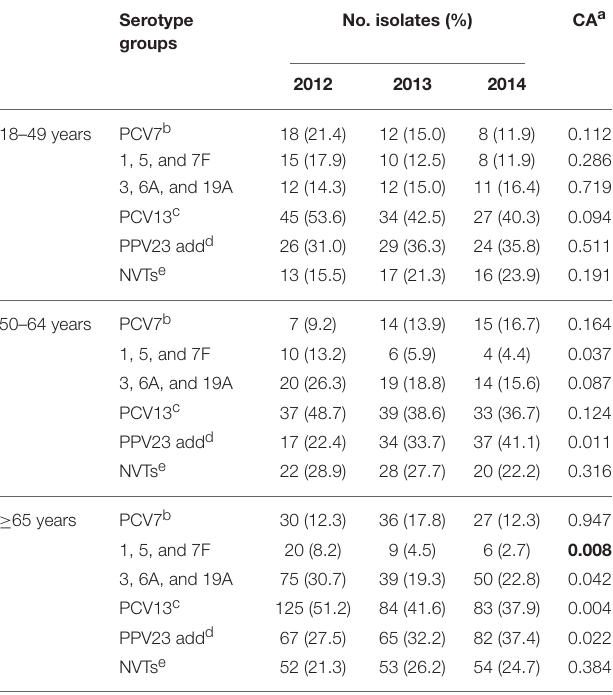
TABLE 3 | Antimicrobial resistance of the isolates responsible for invasive pneumococcal disease in adult patients ( ≥ 18 years) in Portugal,